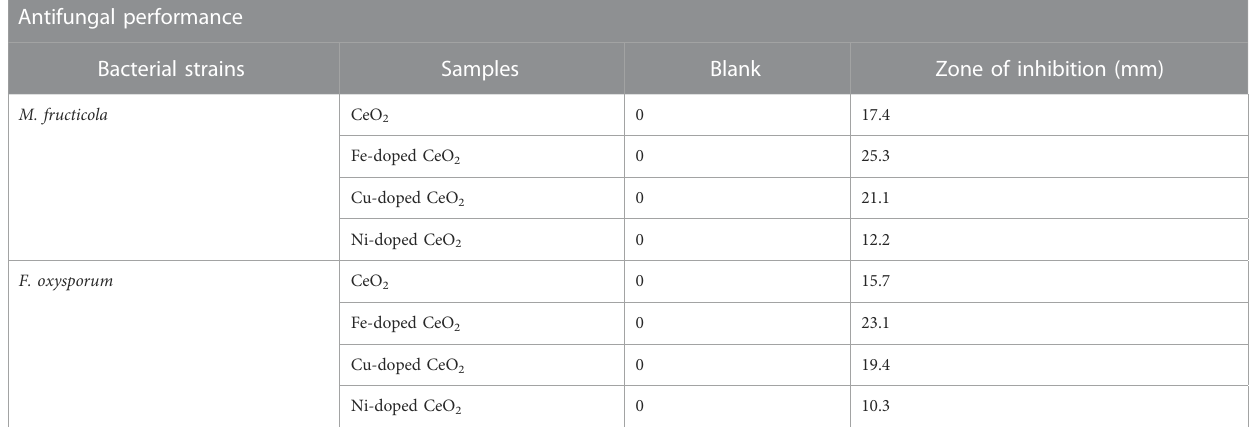
TABLE 1 Agar Well cut diffusion method zone of inhibition for the antifungal action of CeO 2 , Fe-doped CeO 2 , Ni-doped CeO 2 and Cu-doped CeO 2 . Antifungal performance Bacterial strains Samples Blank Zone of inhibition